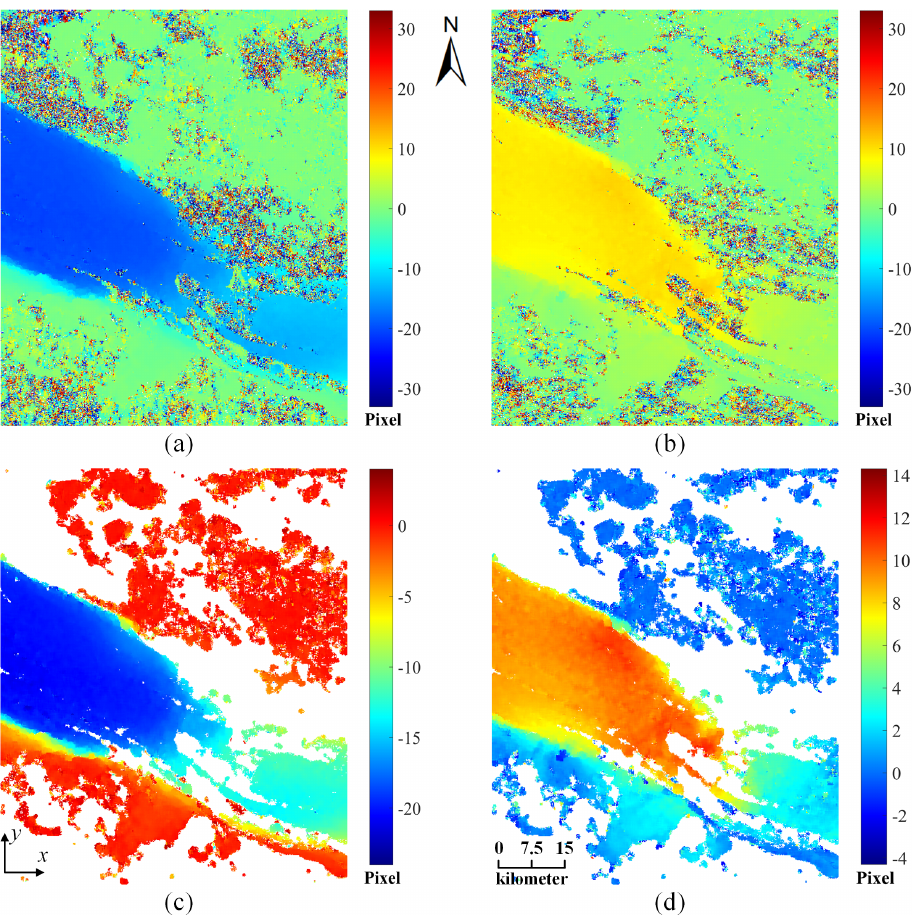
Figure 7. ( a ) x-direction and ( b ) y-direction displacement maps of the Pine Island Glacier derived from the LUGC method; ( c ) x-direction and ( d ) y-direction displacement maps after outlier removal.